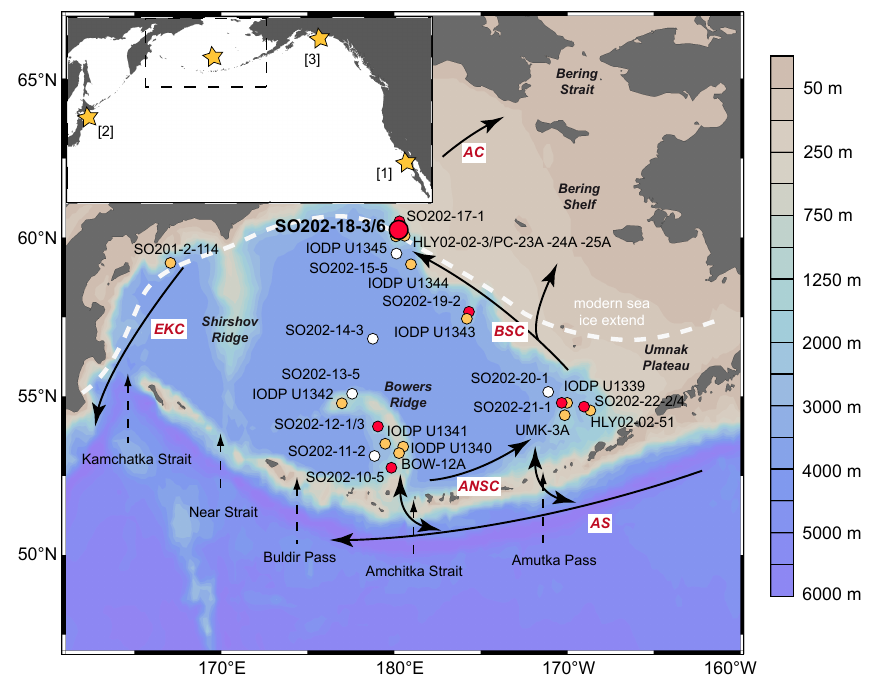
Figure 1. Bathymetric map of the Bering Sea with the position of laminated INOPEX cores (red circles) and INOPEX cores without laminations (white circles). Yellow circles mark the position of published laminated records in the Bering Sea (see Table 1 for details). The surface circulation is shown by black arrows. [AC]: Anadyr Current; [AS]: Alaska Stream; [ANSC]: Aleutian North Slope Current; [BSC]: Bering Slope Current; [EKC]: East Kamchatka Current. Dashed white line shows modern maximum sea ice extension (Reynolds et al., 2002). Dashed black arrows mark the gateways between the Bering Sea and North Pacific. Yellow stars on the small map mark location of laminated sediment records in [1] Gulf of California and Santa Barbara Basin (e.g., Behl and Kennett, 1996 ; Zheng et al., 2000), [2] near the island of Hokkaido (Ikehara et al., 2006; Shibahara et al., 2007), and [3] the southeast Alaska Margin (Davies et al., 2011). Map drawn with Ocean Data View (Schlitzer,